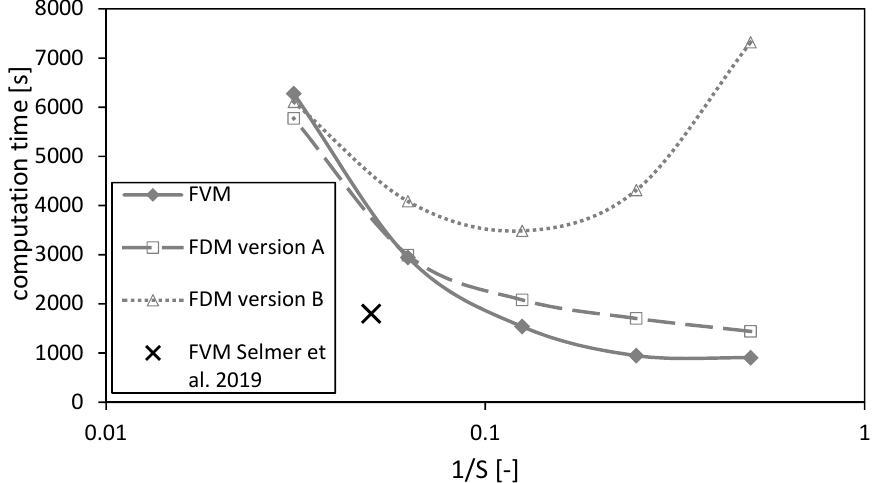
Figure 12. Computation times of the FVM, FDM version A and B and the FVM, with the settings used in Selmer et al. 2019 [3] as function of the reciprocal of the number of nodes S, using x (cid:2870),(cid:2916)(cid:2929)(cid:2930)(cid:2911)(cid:2928)(cid:2930) = 0.05. Calculation settings: N = 26, S REF = 64, Δ t = 0.05 s (for FVM, FDM version A and B), Δ t = 0.1 s (for FVM Selmer et al. 2019 [3]), S = 20 (for FVM Selmer et al. 2019 [3]).